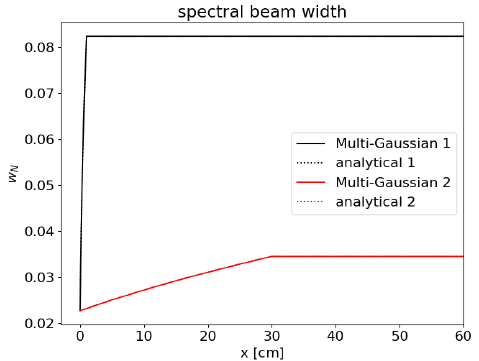
Figure 4. Evolution of the spectral width w N of the beam along the propagation axis x = τ . Comparison of the multi-Gaussian solution (26) and the analytical reference (10) for two sets of fluctuation parameters. Parameters cf. fig. 2.